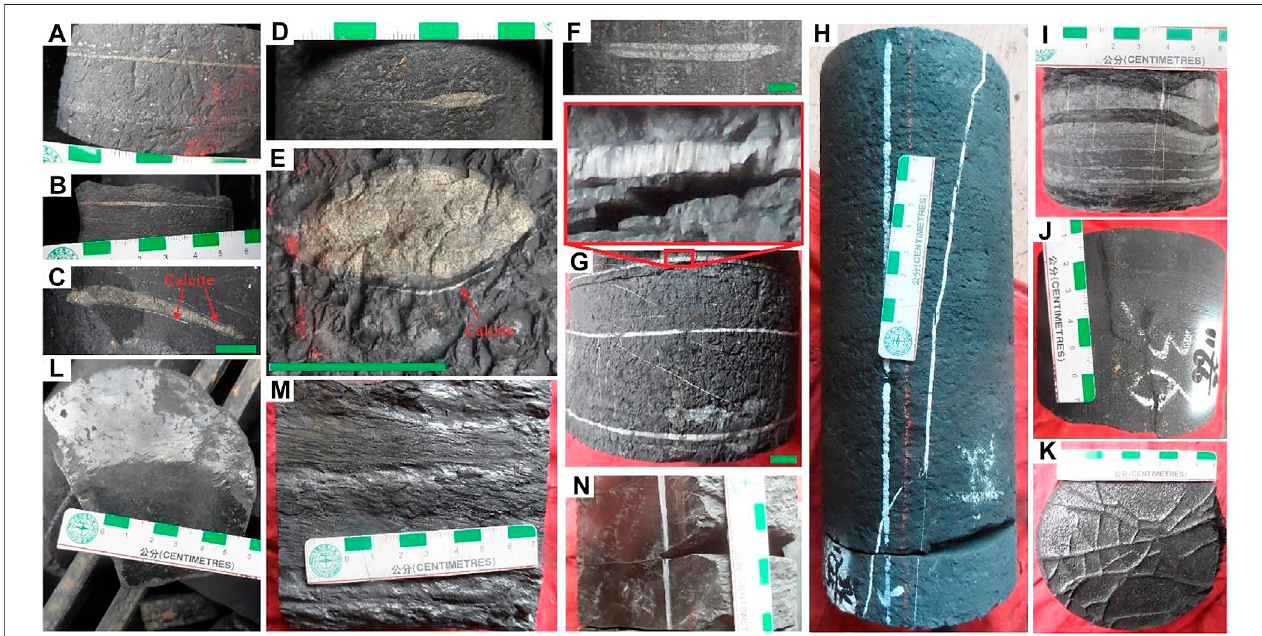
FIGURE 8 | Fracture types and characteristics of Niutitang shale cores in Cen ’ gong block. (A) Straight pyrite- fi lled fracture; (B) horizontal pyrite- fi lled fracture with changedaperture; (C) longstripofpyritenodulesurroundedbycalcite- fi lledfractures; (D) lens-shaped nodulewithlongandshorttips; (E) spindle-shapedpyritenodule with calcite- fi lled fractures at the bottom; (F) bedding-parallel fi brous veins with obvious dark trails of host rock; (G) bedding-parallel fi brous veins, and the fi lling mineral calcite is arranged in a comb shape; (H) subvertical calcite- fi lled fractures, and uneven fracture surface means the changes of fracture propagation direction; (I) fracture aperture changes a lot when cutting off multilayers; (J) vertical clay- fi lled fracture with changed propagation directions; (K) net-shaped fractures with clay and calcite fi lled fracture; (L) horizontal slip fracture with typical mirror structure; (M) vertical slip fracture with step structure; (N) vertical slip fracture with mirror structure.